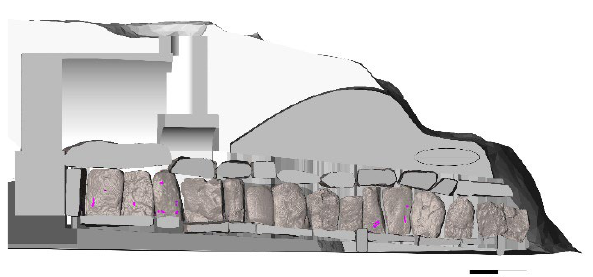
Figure 10. Longitudinal section view of the passage tomb: location of the plastic film (black ellipse) and the scaling zones (purple)